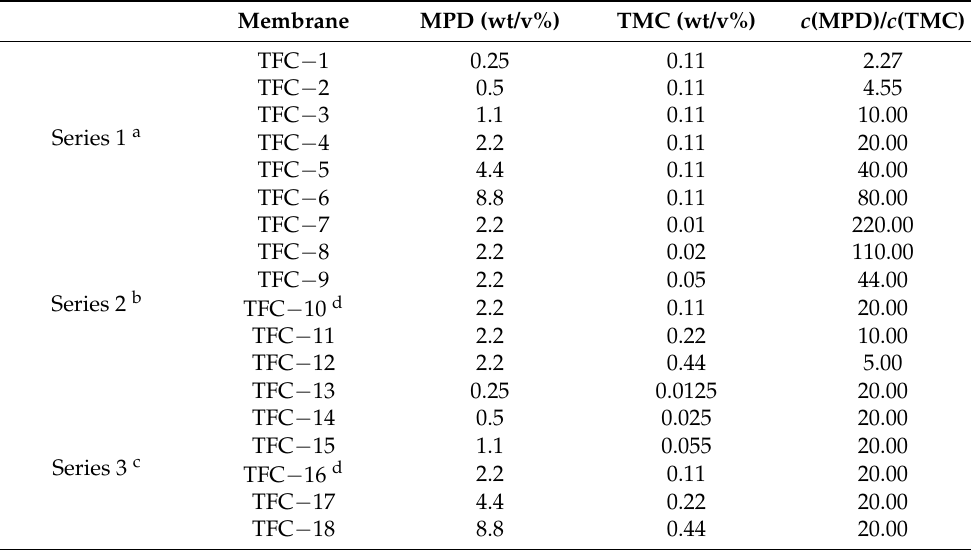
Table 1. Membranes prepared by different reacting monomer